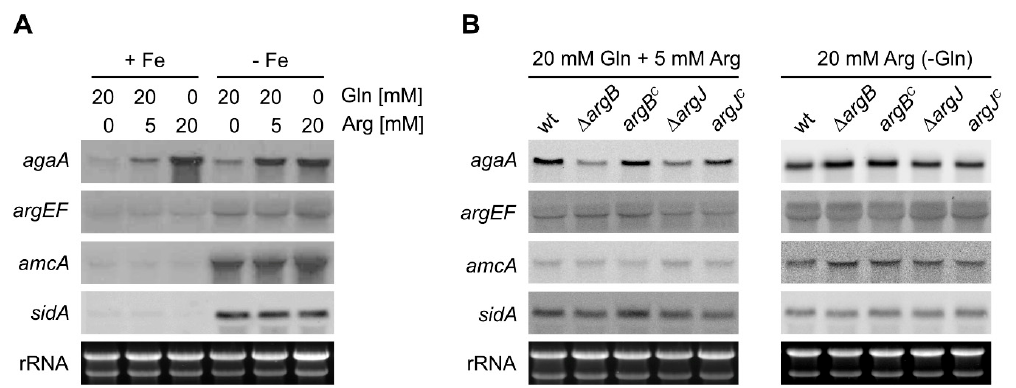
Figure 4. In contrast to argEF, amcA and sidA , expression of agaA is induced by arginine and repressed by nitrogen metabolite repression in wt ( A ); inactivation of either ArgB or ArgJ does not impact the expression of agaA, argEF, amcA, and sidA differently. Fungal strains were grown for 17 h (A) or 22 h (B) at 37 °C in liquid minimal medium under iron sufficiency (+Fe) and iron starvation (-Fe) with the indicated nitrogen sources: 20 mM glutamine (Gln), 20 mM arginine (Arg) or 20 mM Gln plus 5 mM Arg. Ethidium bromide-stained ribosomal RNA is shown for control for RNA loading and quality. 3.5. Deficiency of ArgJ, but Not ArgB, Impairs Growth during Iron-Limited Conditions with Glutamine as Nitrogen Source, When Reductive Iron Assimilation Is Blocked